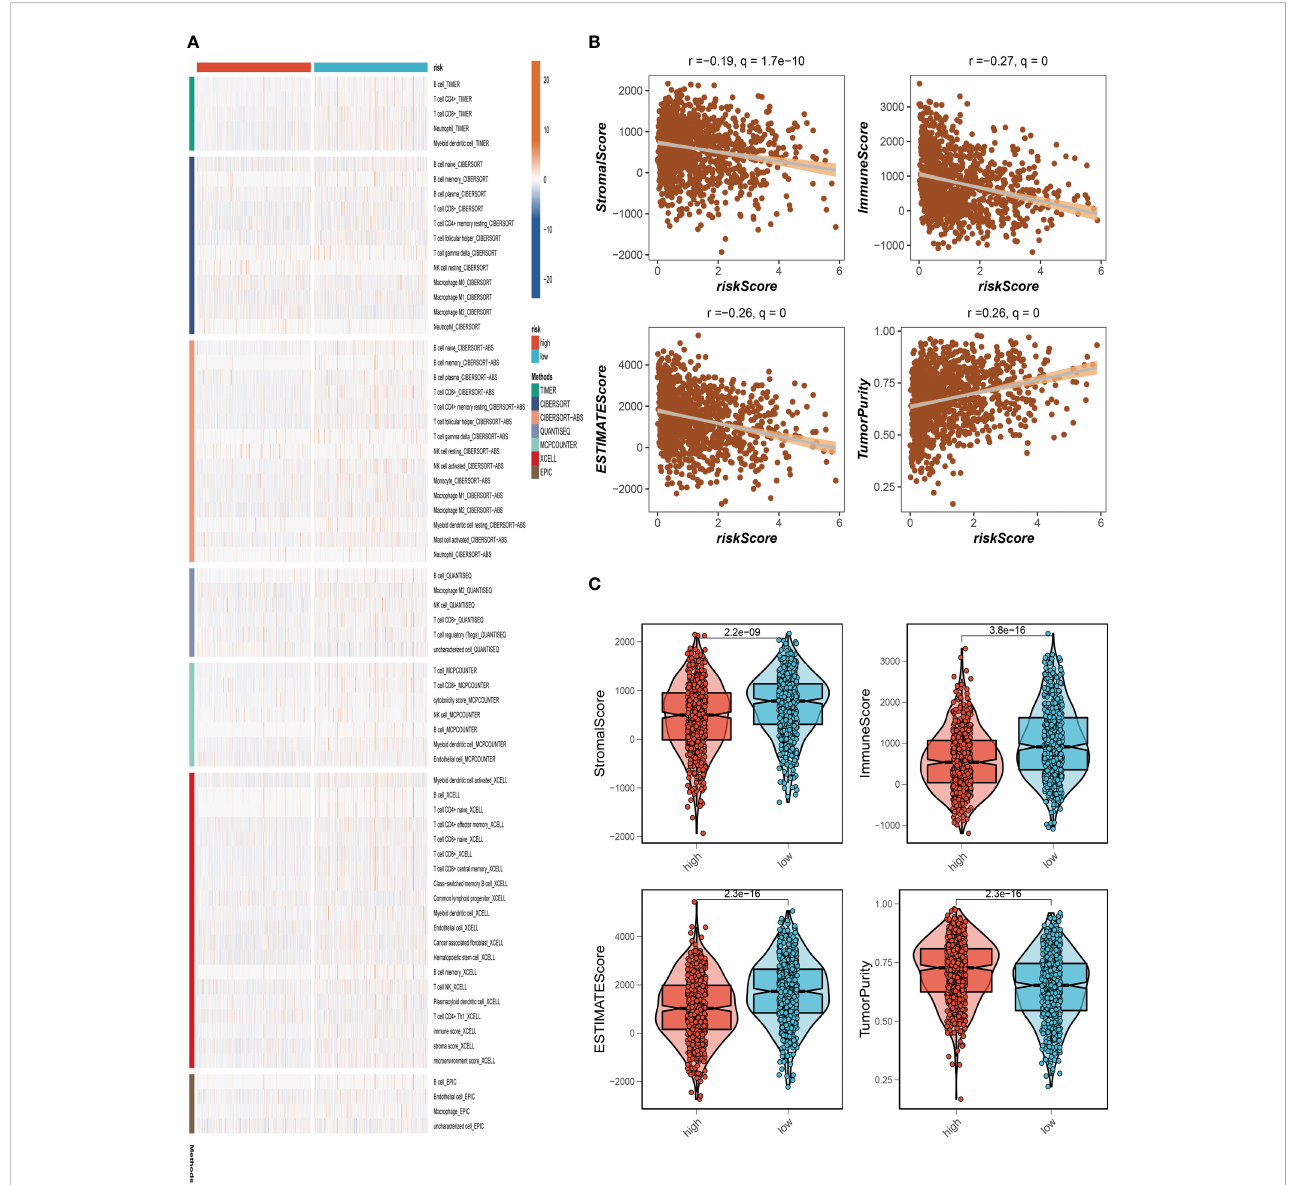
FIGURE 7 Analysis of immune microenvironment. (A) The distribution and association of the 22 tumor-in fi ltrating immune cells (TICs) in the TCGA-BC cohort. (B, C) Correlation analysis of immune score and risk score, ESTIMATE score and risk score, Stromal score and risk score, tumor purity and risk